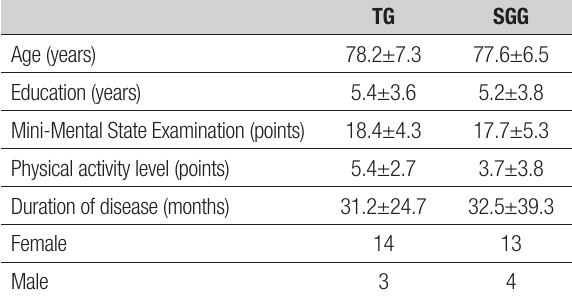
Table 1. Means and standard deviations of variables characterizing the Training Group (TG) and Social Gathering Group (SGG).